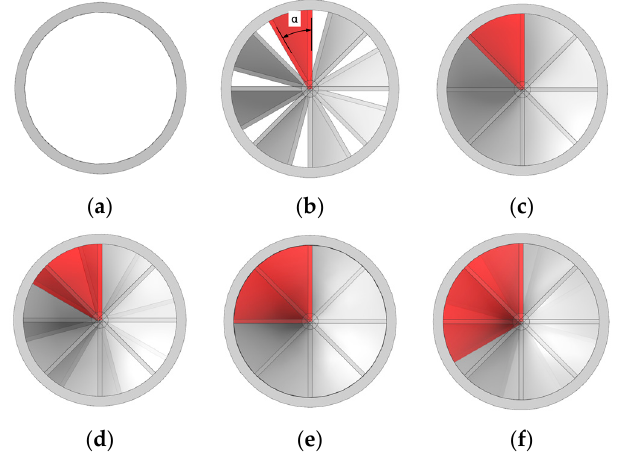
Figure 6. Tubes with different spin angles α : ( a ) smooth tube; ( b ) α = 30°; ( c ) α = 45°; ( d ) α = 60°; ( e ) α = 90°; ( f ) α = 120°.